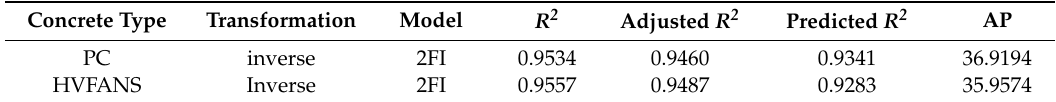
Table 6. ANOVA analysis results.